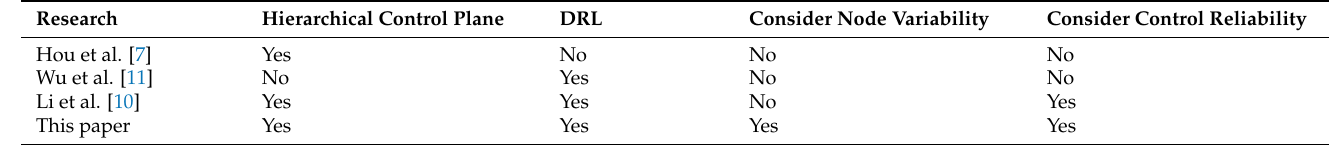
Table 1. Comparison with important